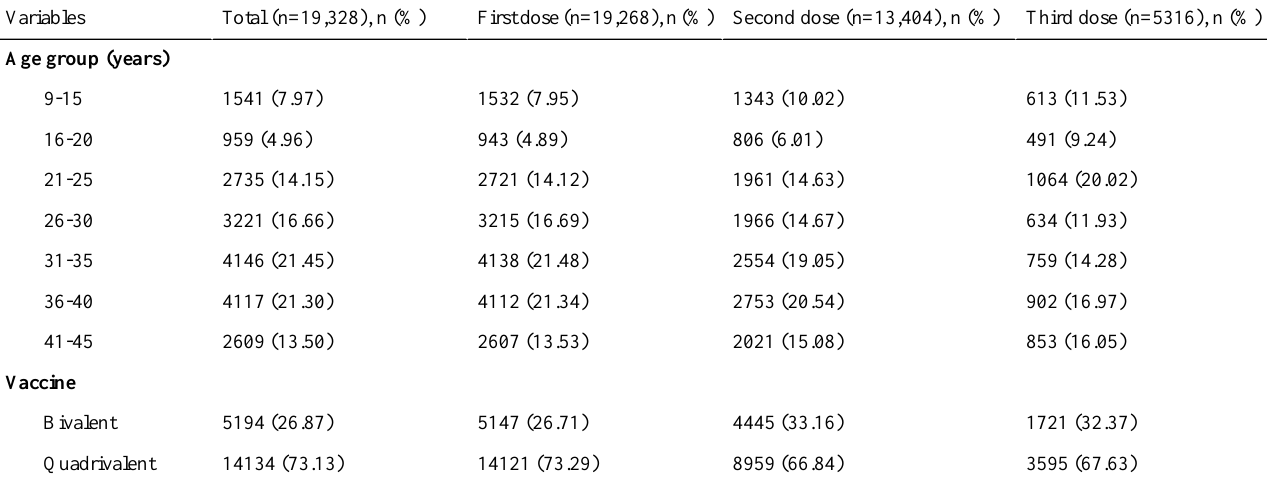
Table 2. Characteristics of the women who underwent HPV